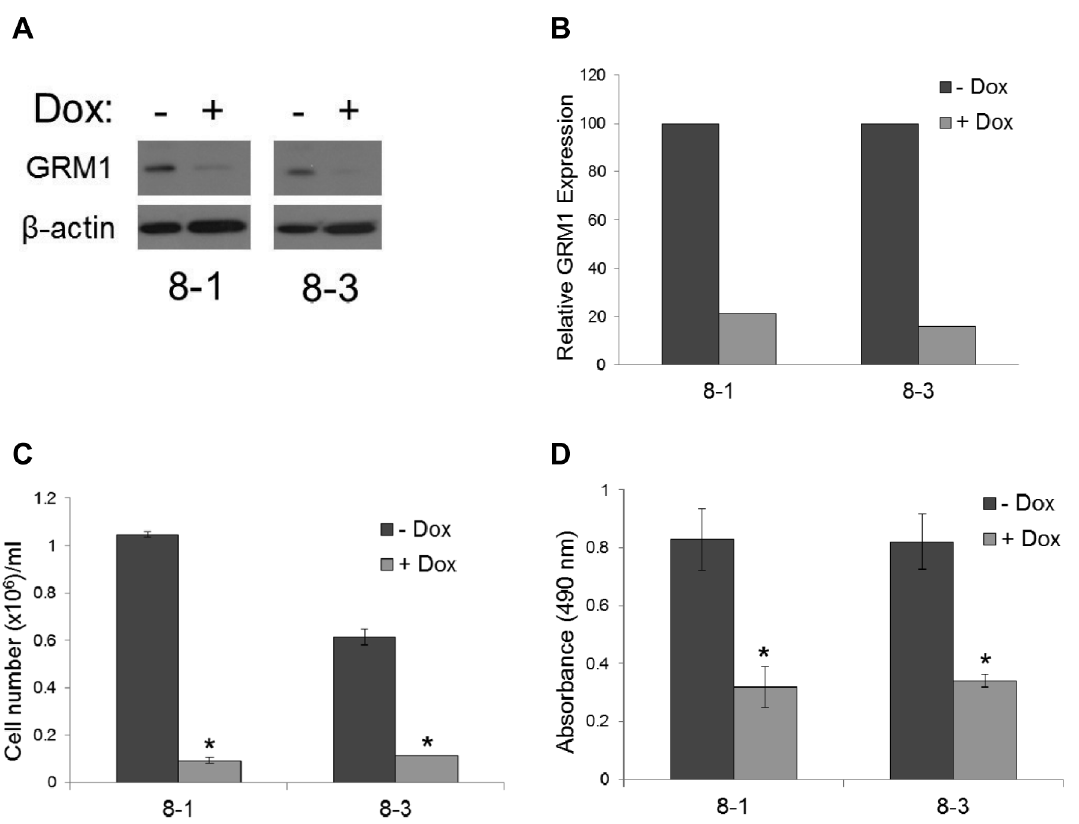
Figure 3. Reduced GRM1 expression alters proliferation of ER + breast cancer cells. (A) Western blot of inducible MCF7 siGRM1 clones (8-1 and 8-3) + / 2 doxycycline (Dox) for ten days. (B) Quantitation of western blots normalizing GRM1 expression to b -actin indicates GRM1 knockdown to 21% and 16% of control in 8-1 and 8-3 clones, respectively. (C) Cell number is significantly reduced in cells with GRM1 knockdown as compared to control cells. (D) GRM1 knockdown decreases cell proliferation as compared to control cells as measured by MTS assay. In (C) and (D), data represent the mean value of triplicate experiments + / 2 SD. * P , 0.05.